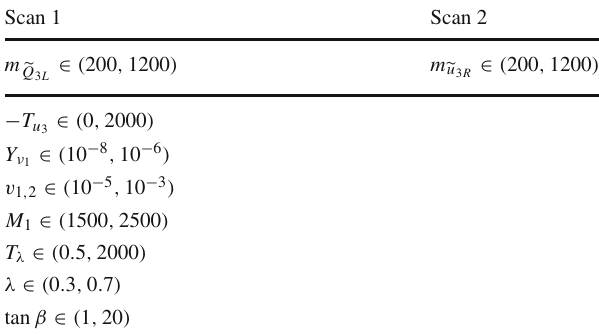
Table 1 Range of low-energy values of the input parameters that are varied in the two scans. The VEVs v i and the soft SUSY-breaking , T λ and M parameters m (cid:4) Q , m (cid:4) u , T u 1 are given in GeV. Relations 3 3 R 3 L v